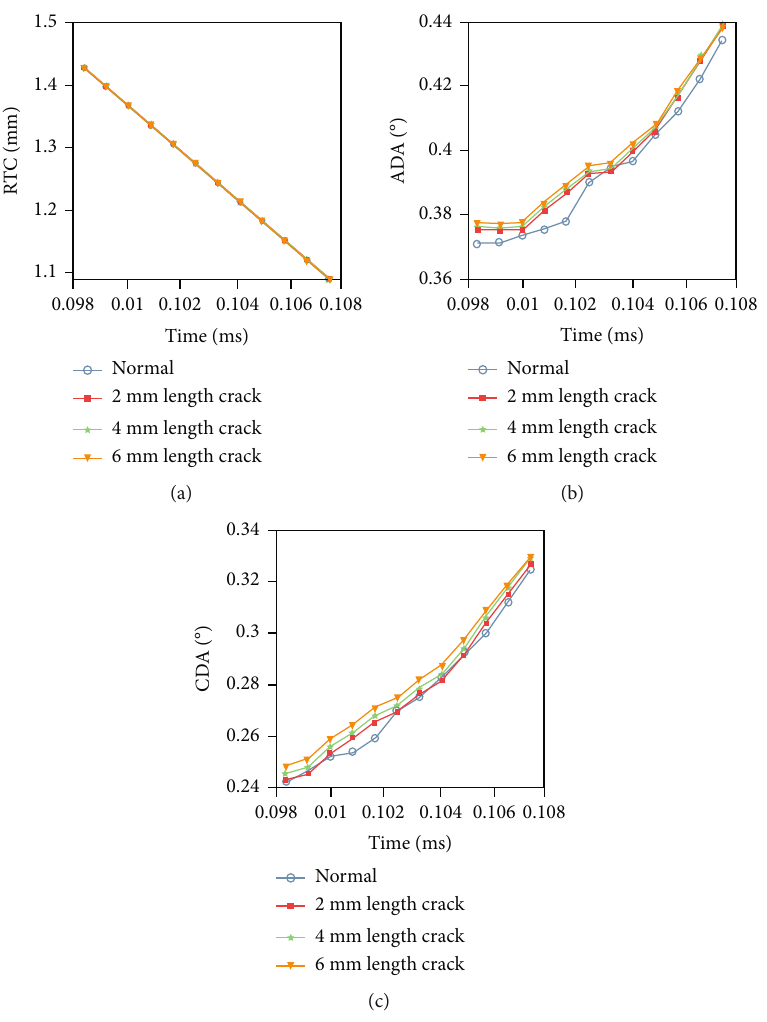
Figure 19: The 3D-BTC of blades with surface cracks of di ff erent lengths. (a) RTC (b) ADA. (c)